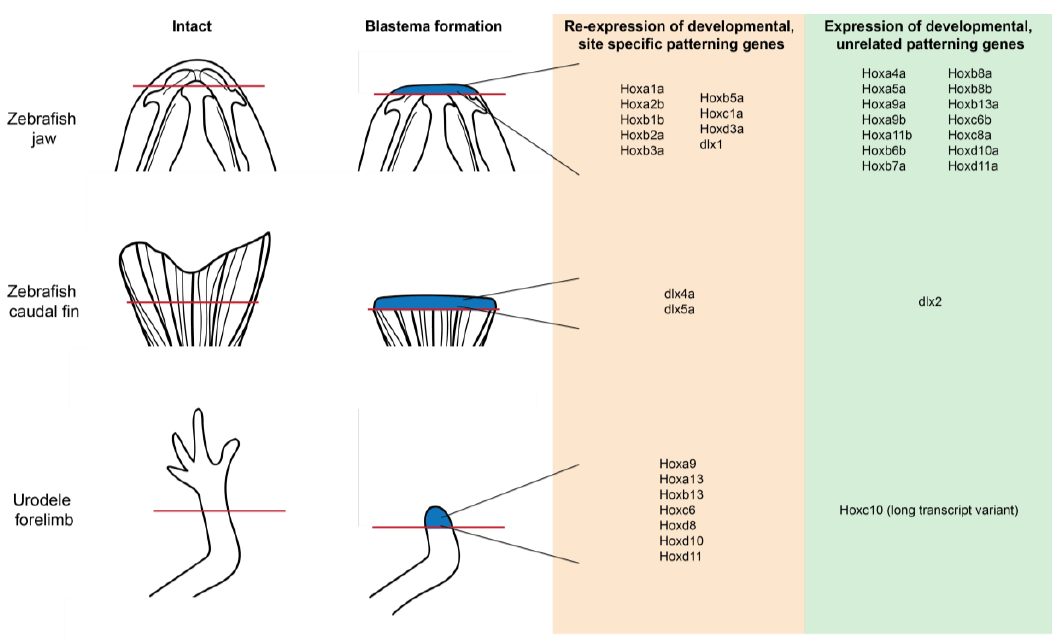
Figure 4. Hox gene re-expression is a characteristic of regeneration shared between species and anatomical locations. Jaw, limb and tail blastema tissue exhibit the re-expression of both developmentally related and unrelated Hox genes. Red line indicates plan of amputation; blue tissue indicates blastema